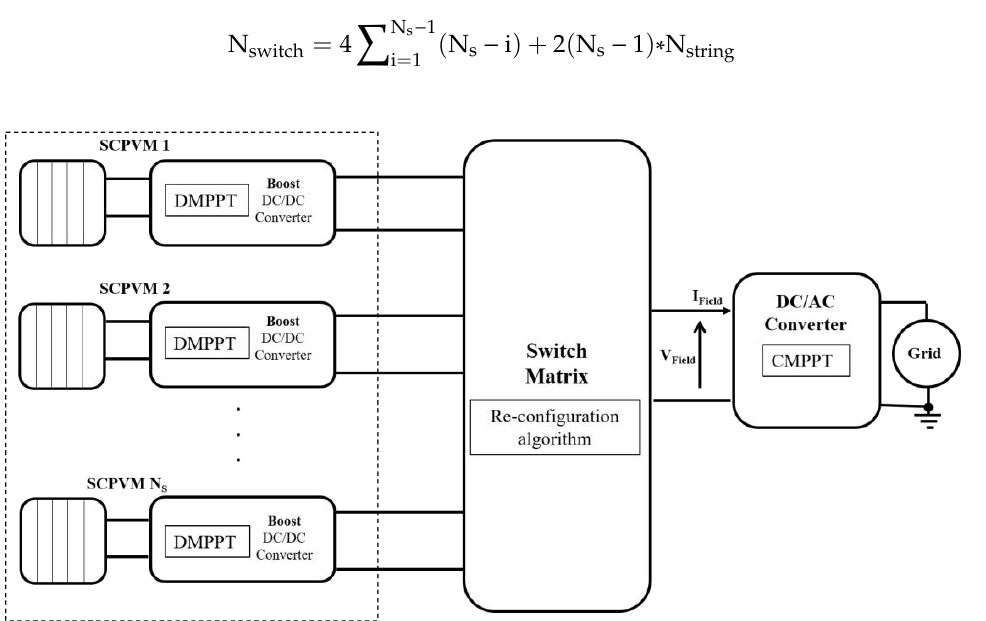
Figure 13. Block scheme of grid-connected PV system with the joint adoption of DMPPT and reconfiguration approaches.